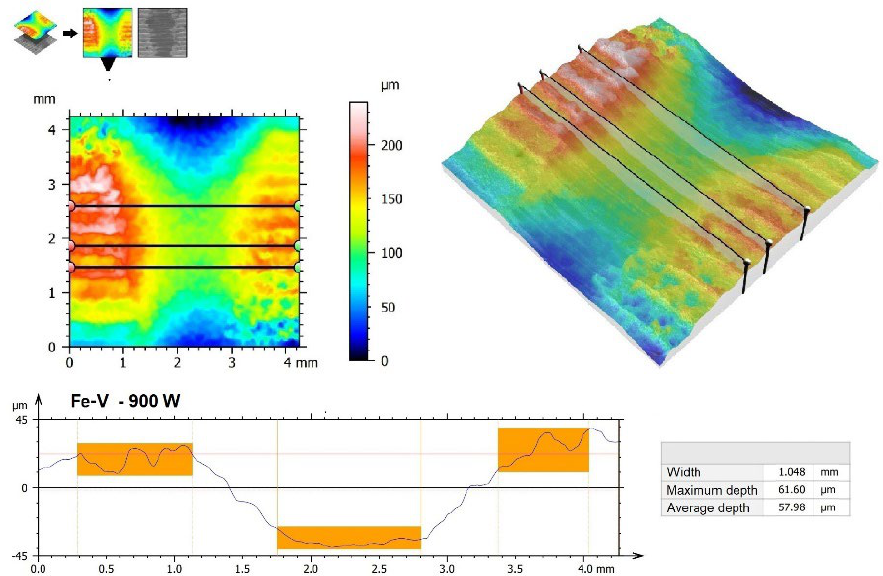
Figure 13. The 3D wear profiles obtained after the wear resistance test of the coating produced by 900 W.